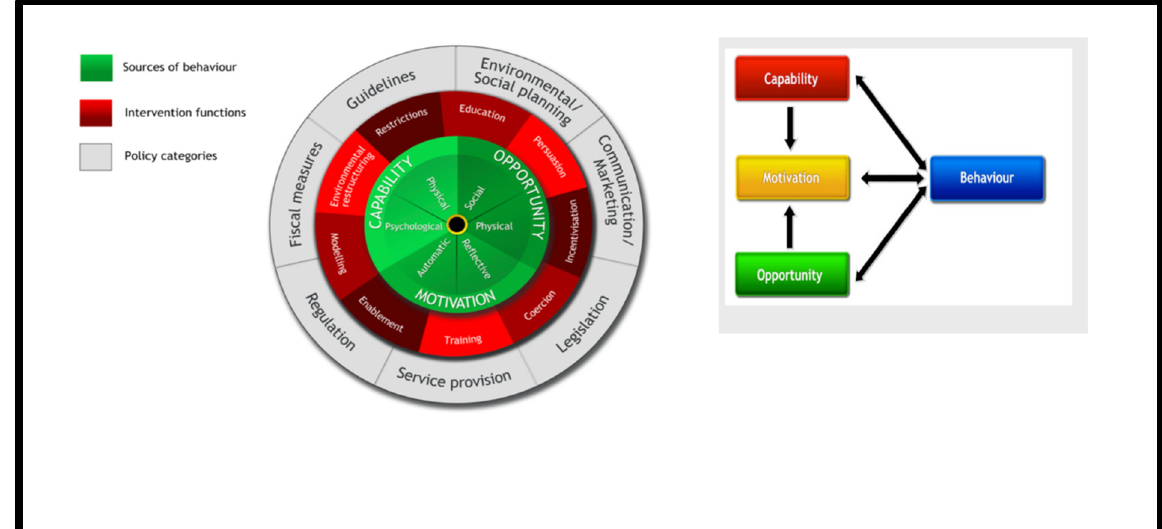
Figure 1. The Behaviour Change Wheel and COM-B model, adapted from ref. [13].